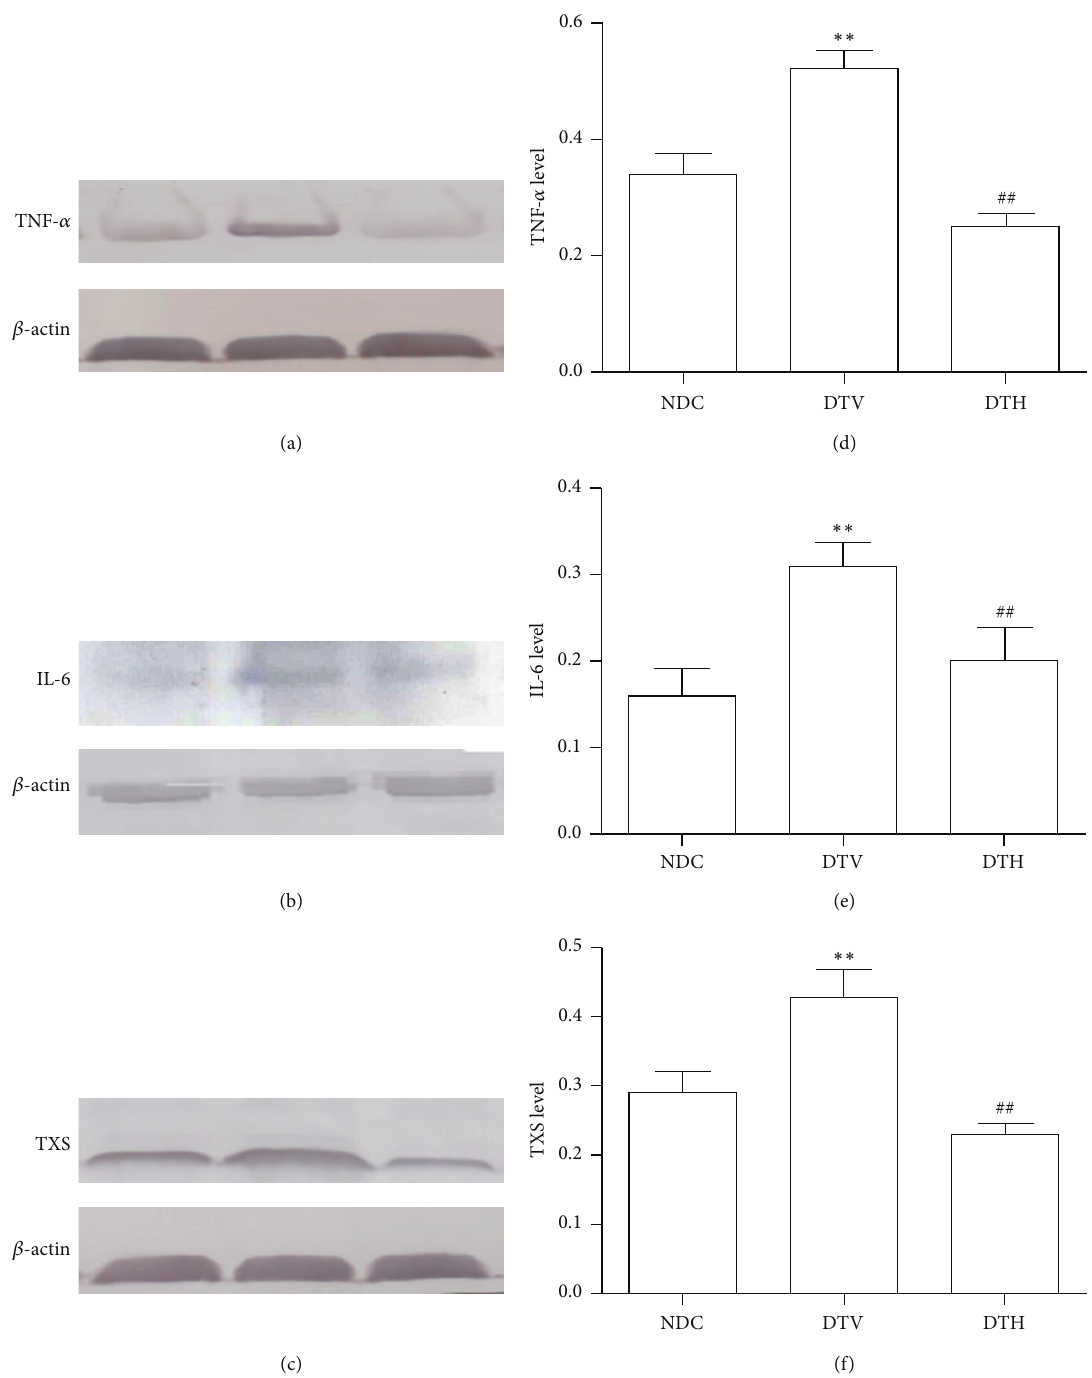
Figure 3: Induction of HO-1 elevated anti-inflammation in diabetic rats. HO-1 decreased expressions and relative levels of TNF- 𝛼 ((a) and (d)), IL-6 ((b) and (e)), and TXS ((c) and (f)) ( ∗∗ 𝑃 < 0.01 versus NDC; ## 𝑃 < 0.01 versus DTV).